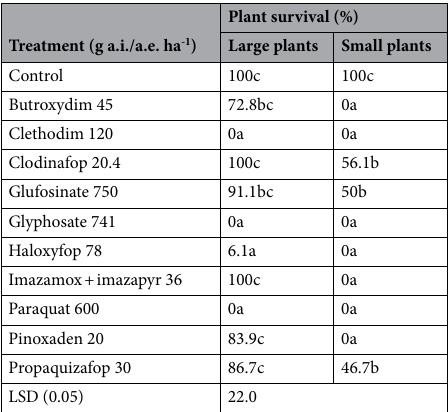
Table 3. The interaction effect of plant size (large plants-10 leaves and small plants-4 leaves) and herbicide treatments on the survival of Phalaris paradoxa seedlings at 28 d after spray. The means sharing letter(s) are statistically